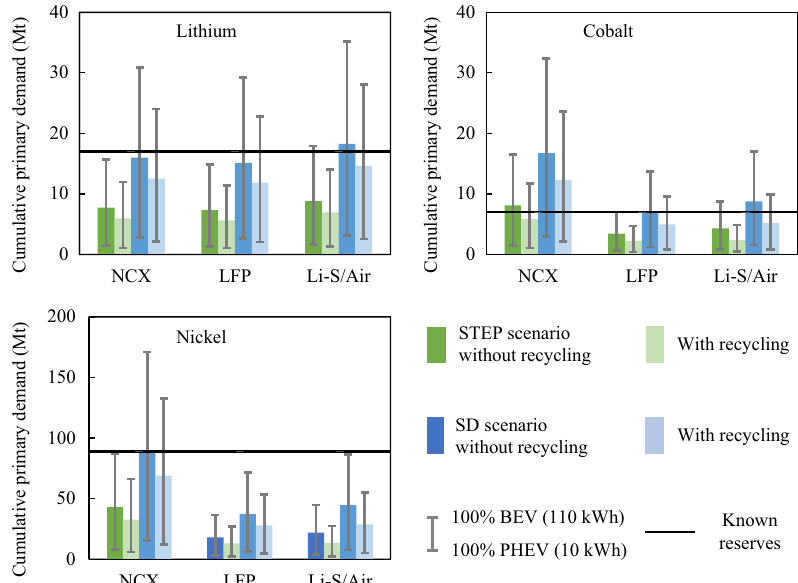
Fig. 4 Cumulative primary material demand in 2020 – 2050 without recycling and with hydrometallurgical recycling. Gray error bars represent a sensitivity analysis for battery capacity considering two extreme cases (if all EVs were PHEVs with small 10 kWh batteries or if all EVs were large SUVs with 110 kWh batteries, e.g., Tesla ’ s Model S Long Range Plus 37 , see annual results in Supplementary Fig. 10). See Supplementary Fig. 11 for other materials. The black line represents known reserves 32 . STEP scenario the Stated Policies scenario, SD scenario Sustainable Development scenario, Mt million